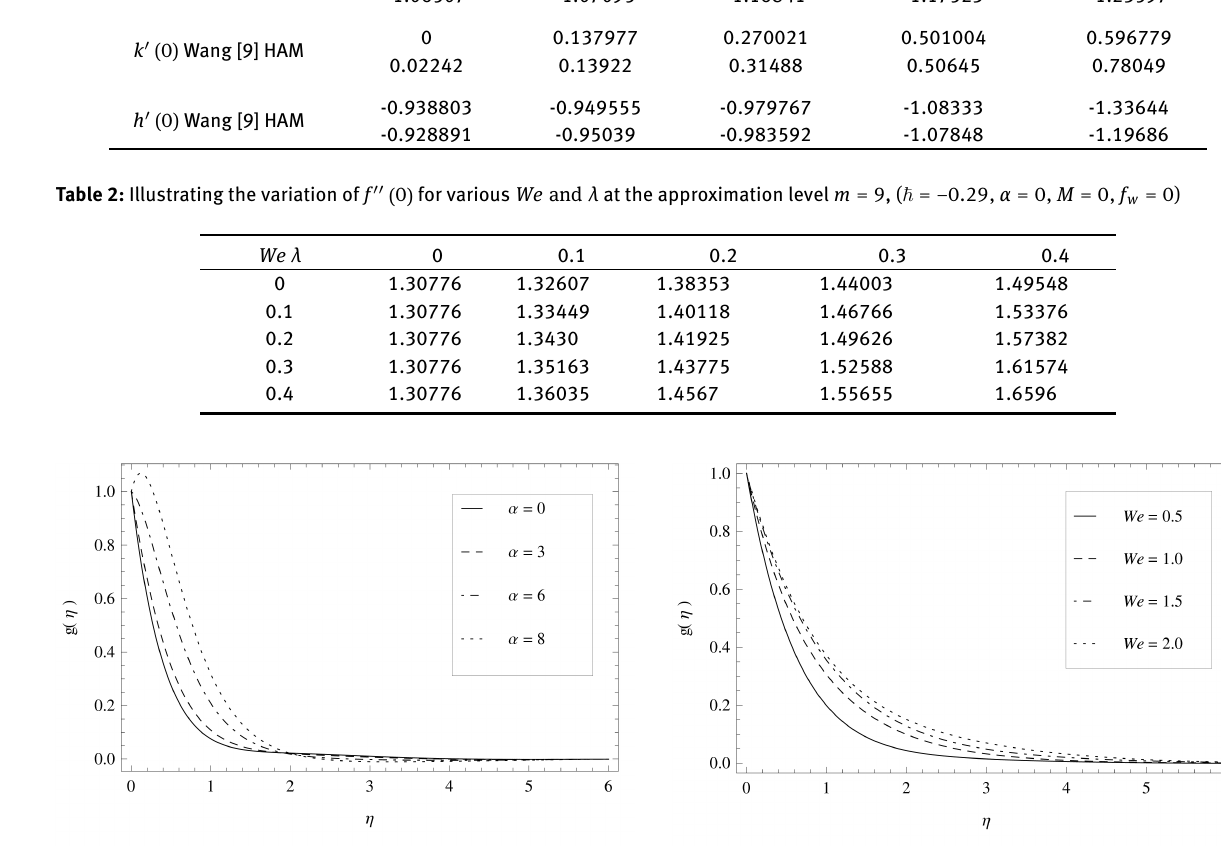
Fig. 8: The influence of a parameter We on g ( η ) for λ = 0.5, α = 2, M = 1, f = 1.5 and (cid:126) = w